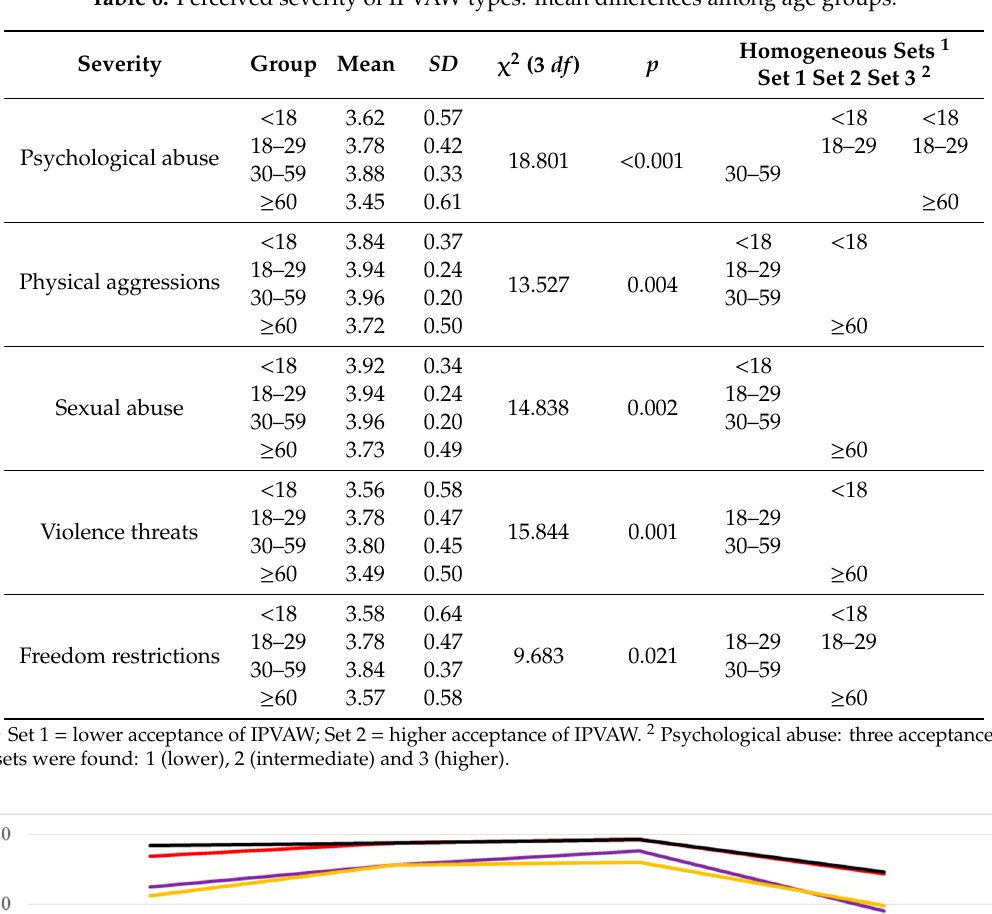
Table 6. Perceived severity of IPVAW types: mean di ff erences among age groups.